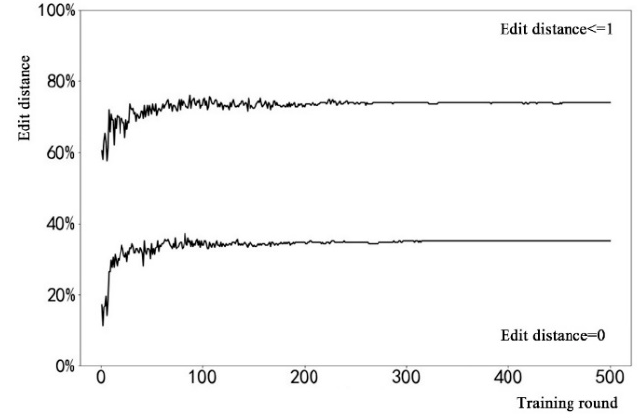
Figure 11. Variation diagram of the simulation accuracy of the RNN model.